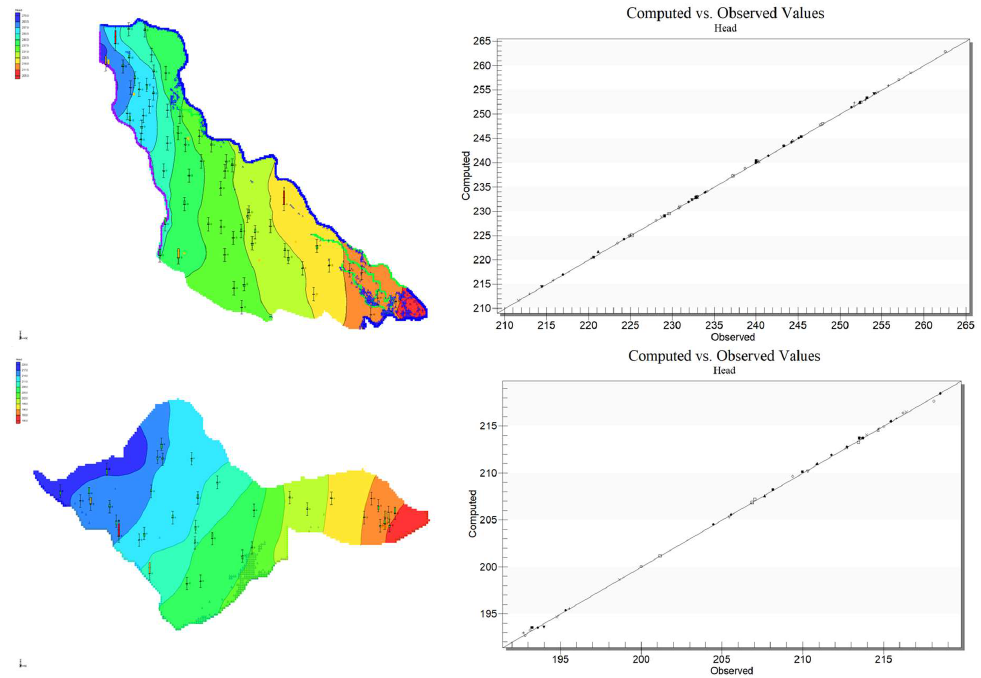
Figure 8. Modelled hydraulic heads in the Dravsko polje aquifer; left—model results with observation points in relation to modelled data; right—Comparison between computed and observed hydraulic heads on the Dravsko polje aquifer (above). Modelled hydraulic head in the Ptujsko polje aquifer; left—model results with observation points in relation to modelled data, where the deviation is less than 0.25 m, marked with a green line, right—deviation between computed vs. observed values in the Ptujsko polje aquifer